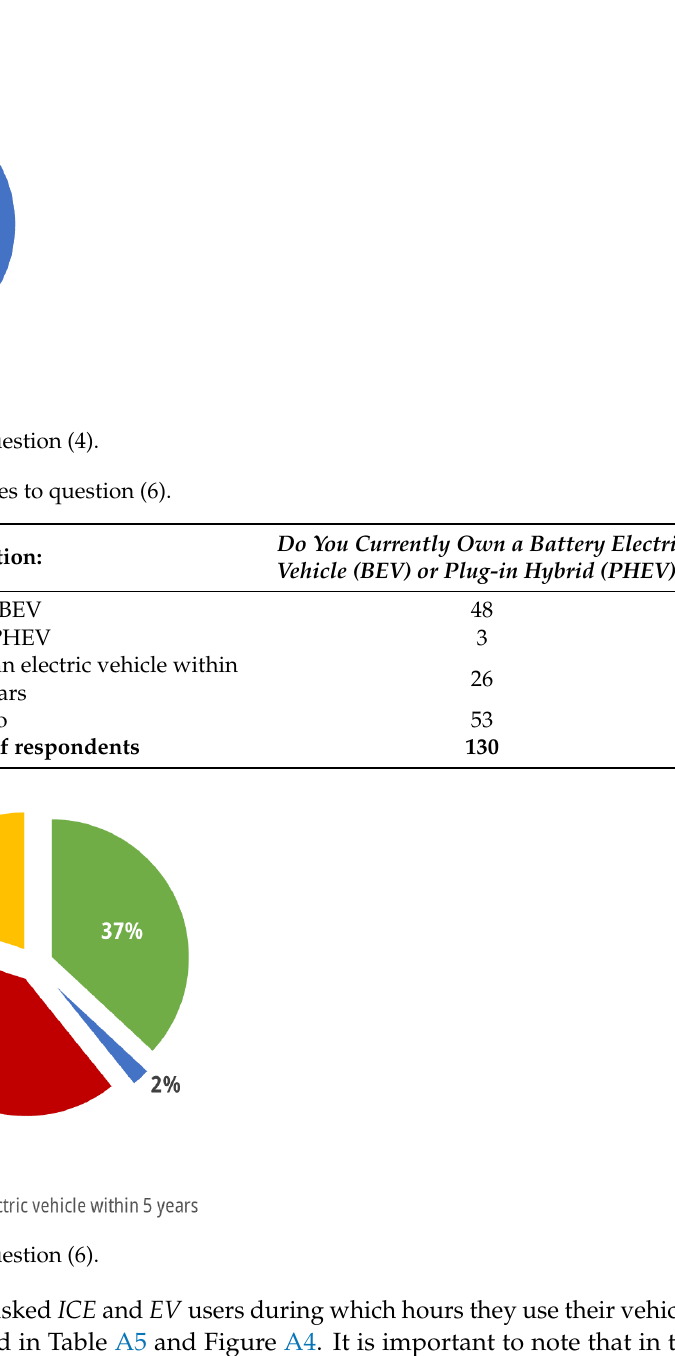
Table A5. Detailed responses to questions (5) and (7)—multiple-choice.